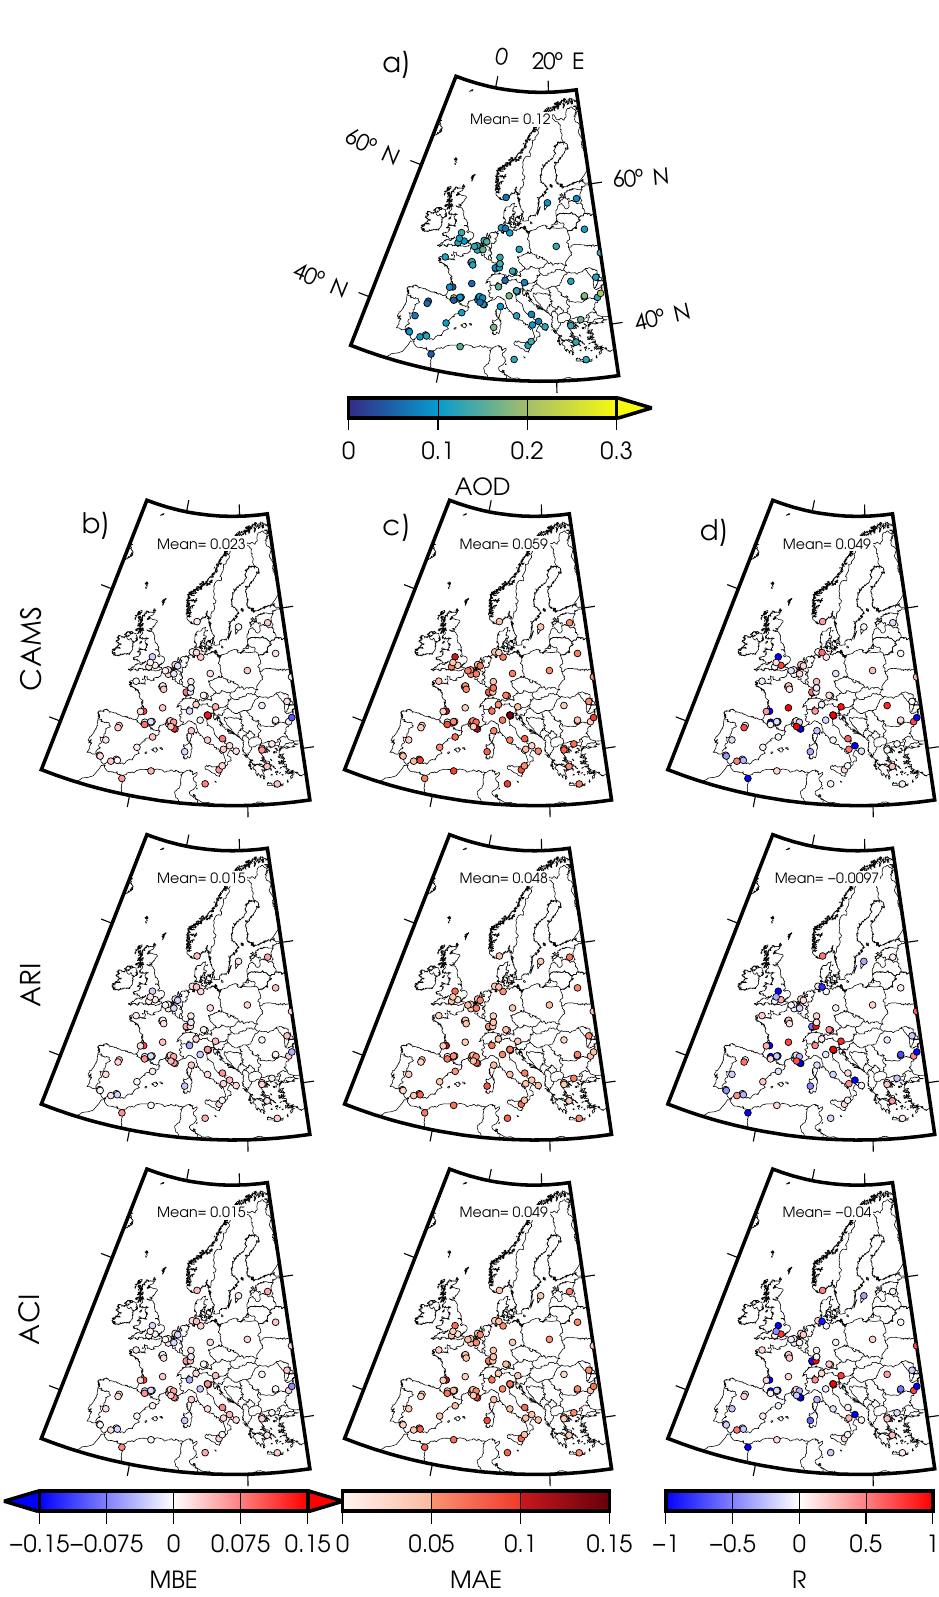
Figure 2. ( a ) Mean monthly aerosol optical depth (AOD) at 670 nm from AERONET, averaged for the target period. ( b ) Mean bias error (MBE); ( c ) mean absolute error (MAE), and ( d ) temporal correlation for Copernicus Atmosphere Monitoring Service (CAMS) (R) (top), ARI-base case (centre) and aerosol-cloud interactions (ACI) simulation